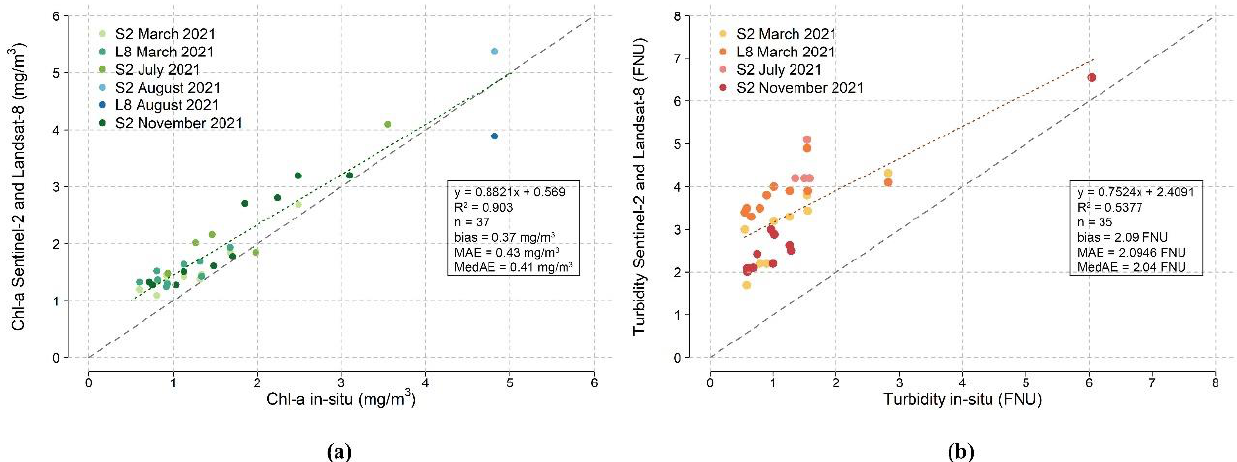
Figure 8. Validation of water quality parameters obtained with Sentinel-2 (S2) and Landsat-8 (L8) during the four in situ campaigns carried out in March, July, August, and November 2021 for ( a ) chlorophyll-a concentration (chl-a, mg/m 3 ) and ( b ) turbidity (FNU).